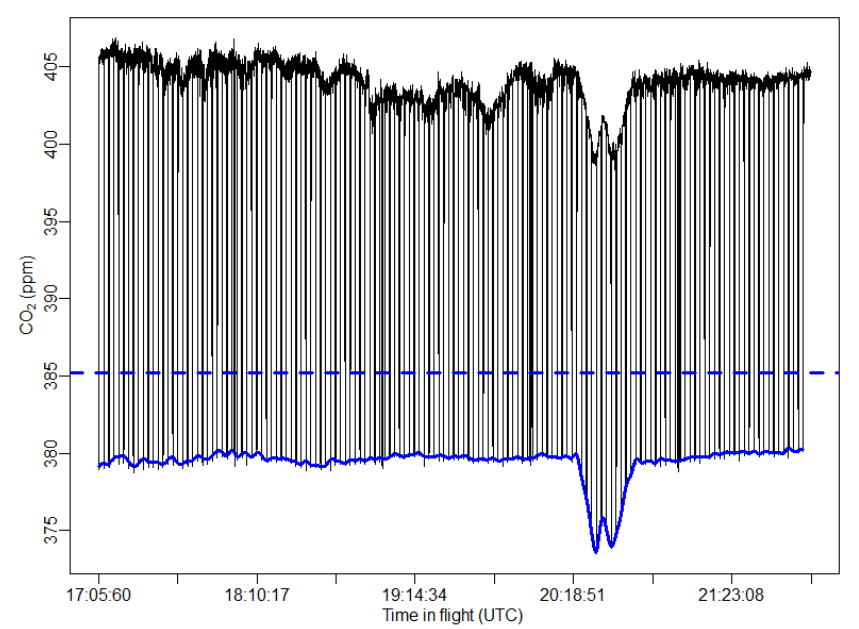
Figure 6. Raw CO 2 (black) measured by the FCHAOS for an entire flight, with frequent low dips due to calibrations. The blue dashed line indicates the “true” value of the calibration gas, and the blue solid line shows the calibration curve obtained by interpolating between each calibration instance. The difference between the dashed and solid blue lines is used to correct for